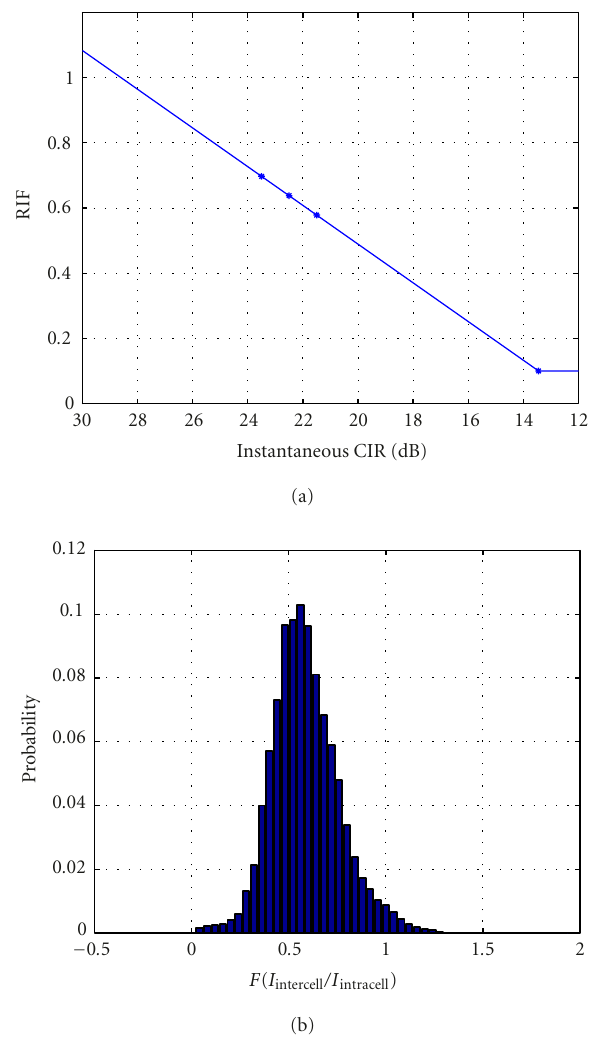
Figure 7: (a) RIF mapping and (b) F distribution over all cells.